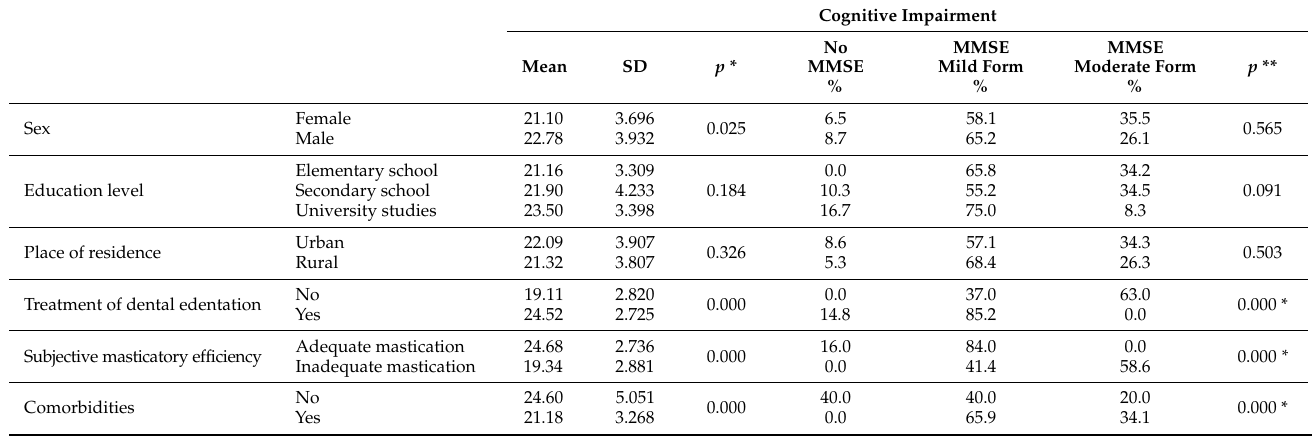
Table 3. Cognitive impairment: means values for general characteristics, edentulism treatment, and masticatory function.